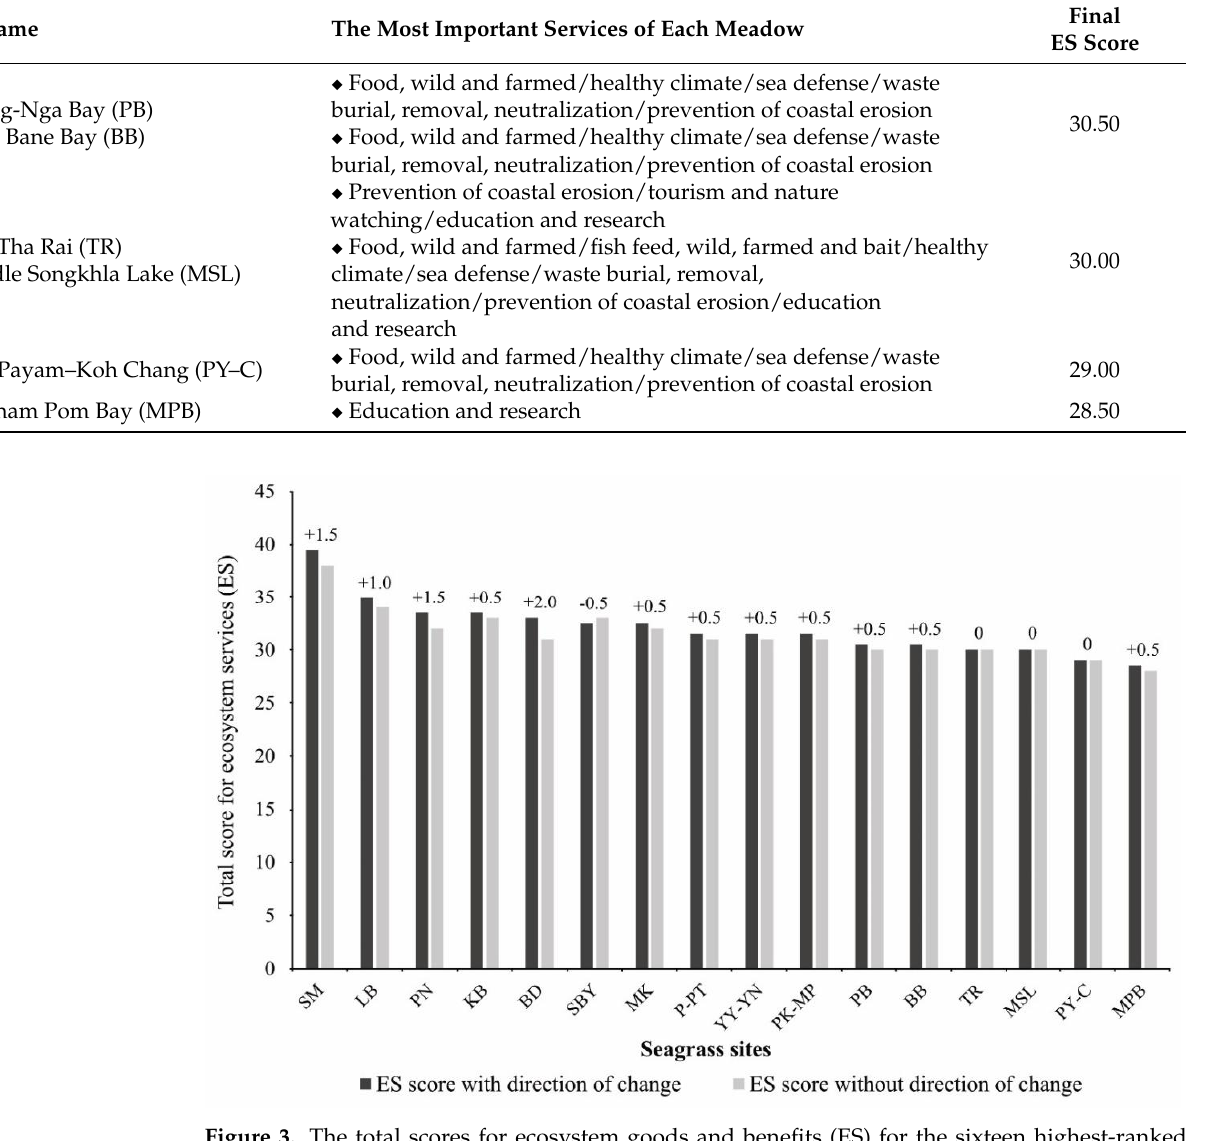
Figure 3. The total scores for ecosystem goods and benefits (ES) for the sixteen highest-ranked seagrass meadows, with and without direction of status change. The number on top of the bar indi- cates the direction of the meadow and its ecosystem-services provision. See Table 1 for site